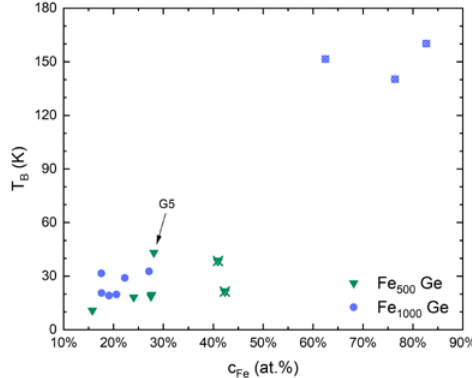
Figure 10. Blocking temperature of all samples (blue circles: Fe 1000 -Ge, green triangles: Fe 500 -Ge) that exhibit magnetoresistance (solid symbols). Some samples not showing magnetoresistance (crossed symbols) are added to the graph despite not being listed in Table 1. Disregarding the highlighted thin sample G5, the blocking temperature increases with concentration and is larger for the nanocomposites containing the larger cluster species.